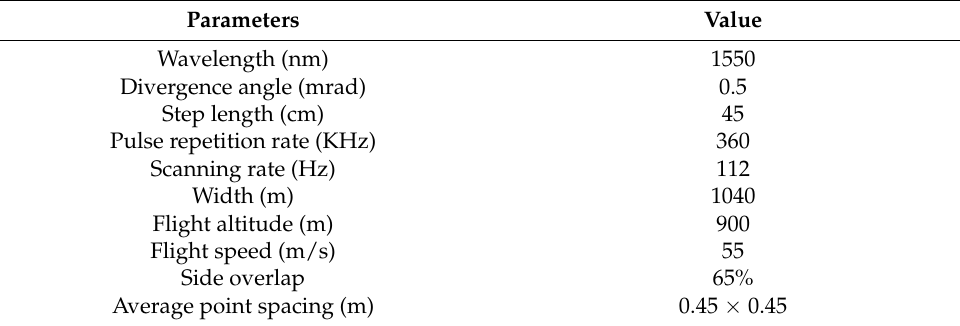
Table 2. Laser scanning system parameters.